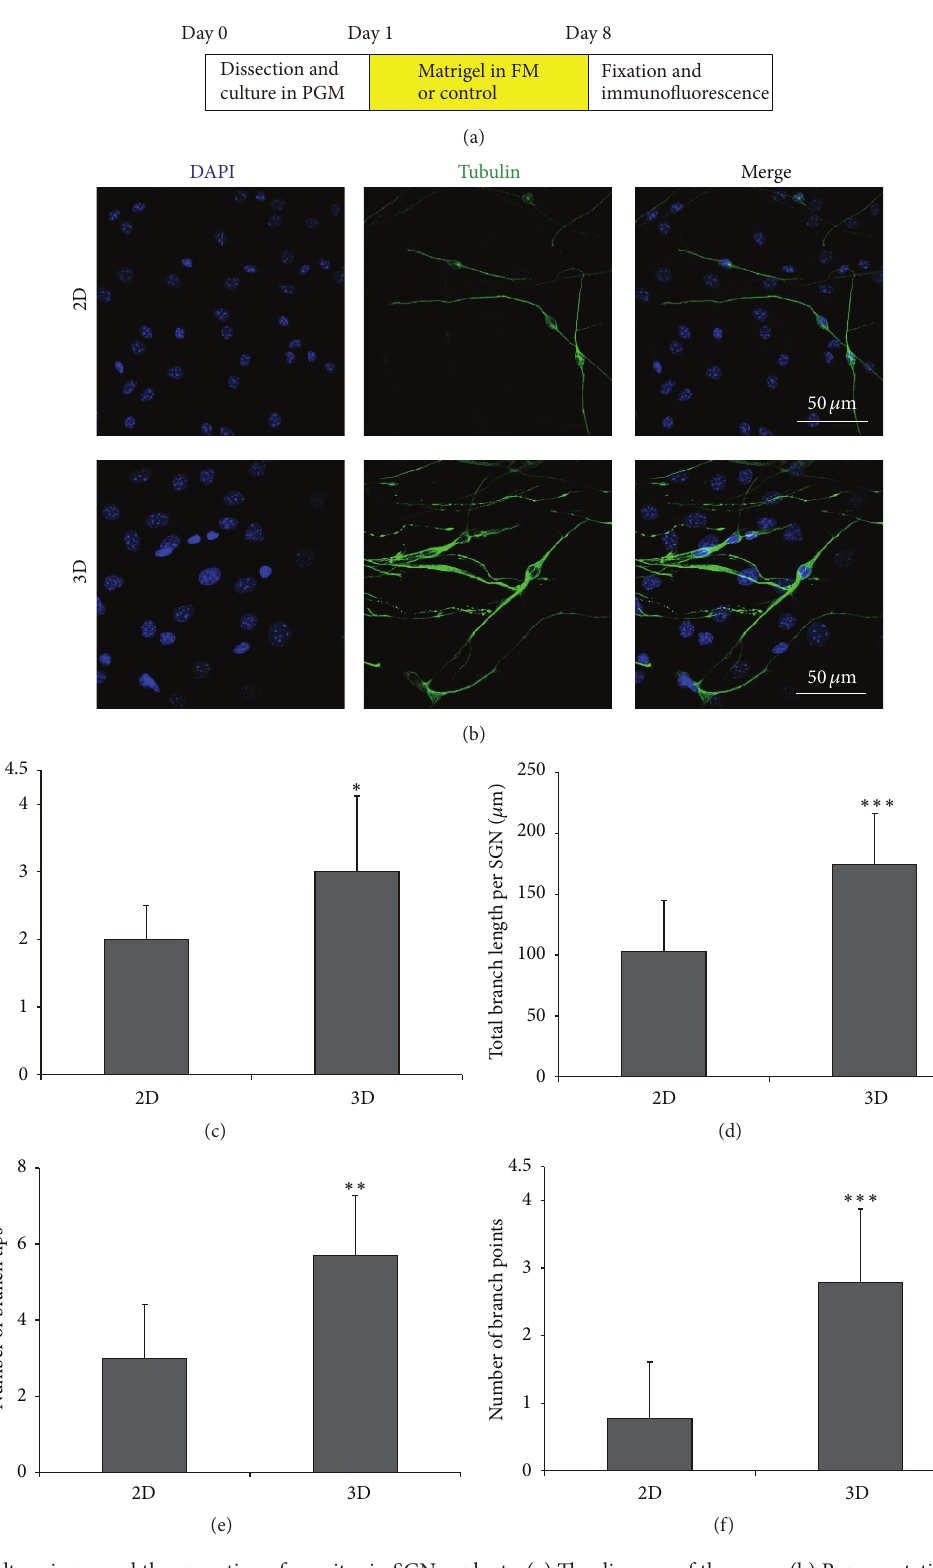
Figure 6: 3D culture improved the sprouting of neurites in SGN explants. (a) The diagram of the assay. (b) Representative images of SGNs explants cultured in 2D and 3D systems. DAPI, blue; 𝛽 -tubulin, green. (c–f) Quantifications of the average number of primary dendrites, total branch length, number of branch tips, and number of branch points in 2D and 3D systems. ∗ 𝑝 < 0.05 , ∗∗ 𝑝 < 0.01 , and ∗∗∗ 𝑝 < 0.001